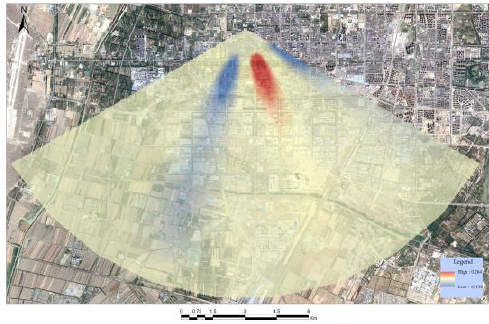
Figure 5. Horizontal scanning results of haze weather Figure 5 shows the observations at 21:30 on March 13, 2018. different from sunny weather. It can be seen from the figure that the overall color of the area is darker than sunny day, and there are small pieces of red patchy pollution sources. It means that the concentration of aerosol particles is large on that day.